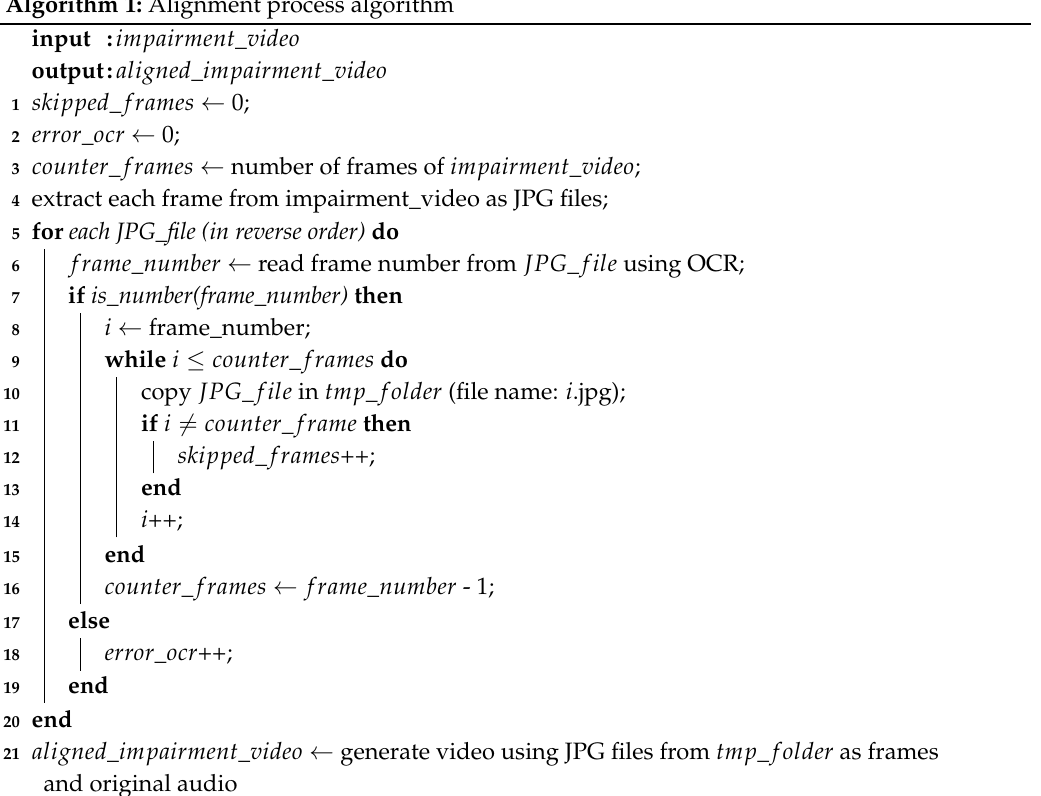
Algorithm 1: Alignment process